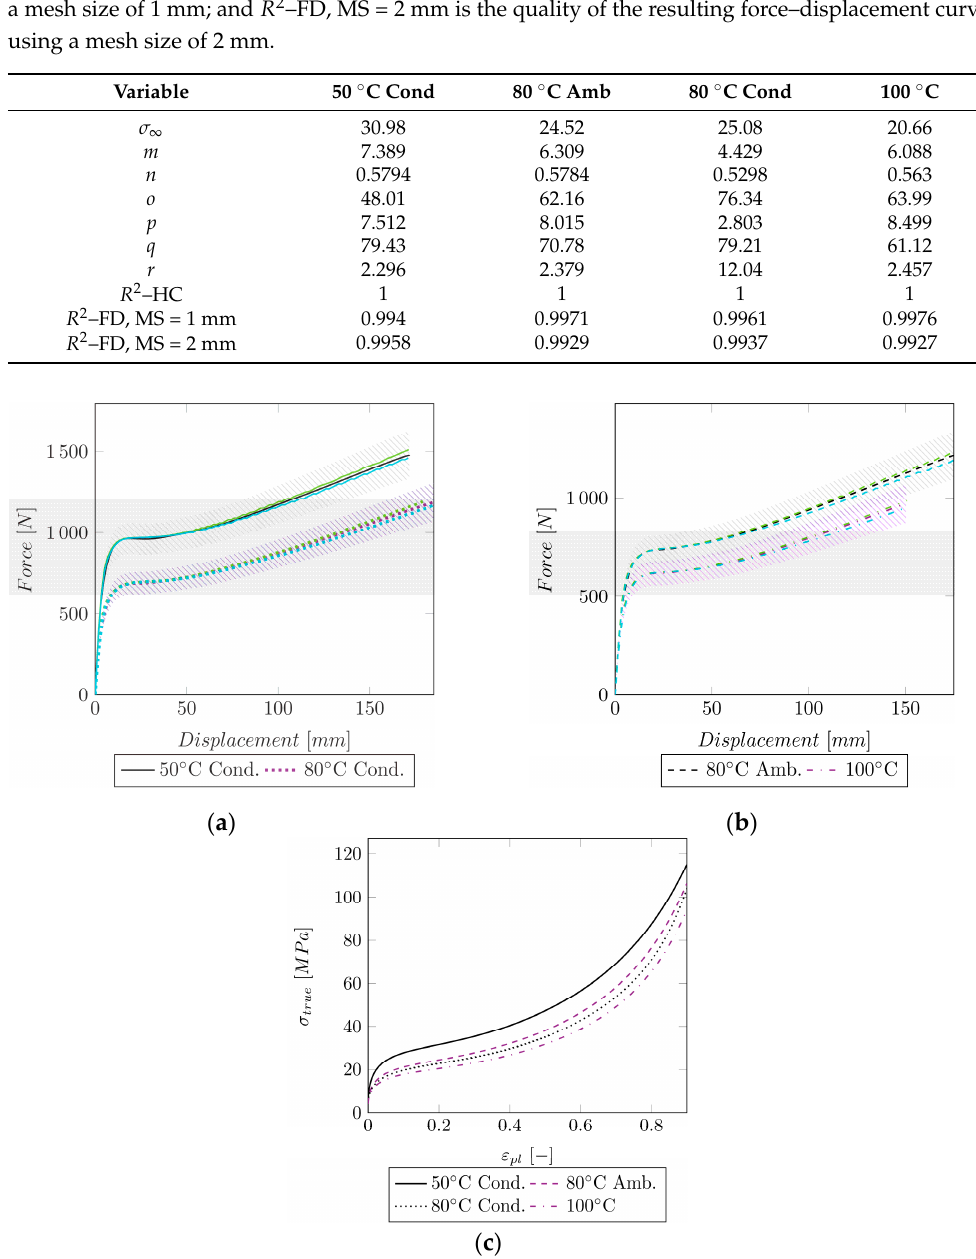
Figure 5. Comparison of the experimental data to the simulation of Group III for two mesh sizes. The shaded area indicates a ±10% force region around the experimental curve. Green: MS = 1 mm, Blue: MS = 2 mm. ( a ) Experimental and simulated force–displacement curves at 50 °C cond and 80°C cond; ( b ) experimental and simulated force–displacement curves at 80 °C ambient and 100 °C; ( c ) HCs for 50 °C (conditioned), 80 °C (ambient/conditioned), and 100 °C for an MS of 1 and 2 mm.